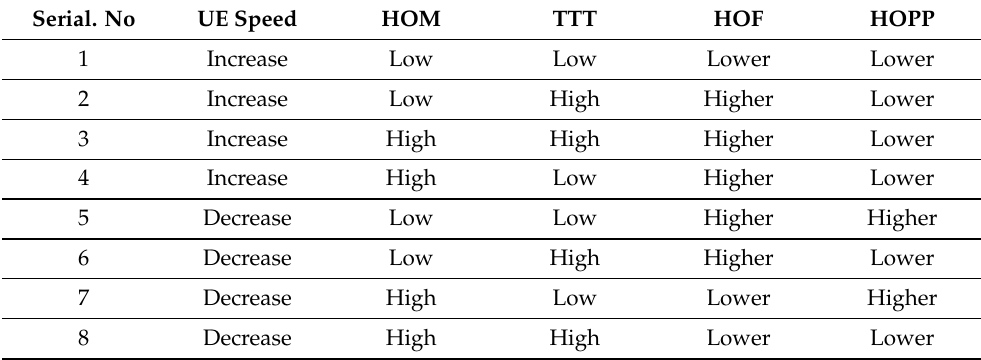
Table 2. Summary of HCP parameters for HOF and